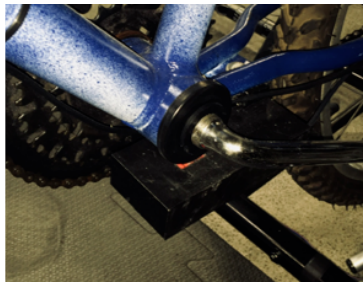
Figure 2. Mouse positioned to capture the axle’s protection cover rotation.